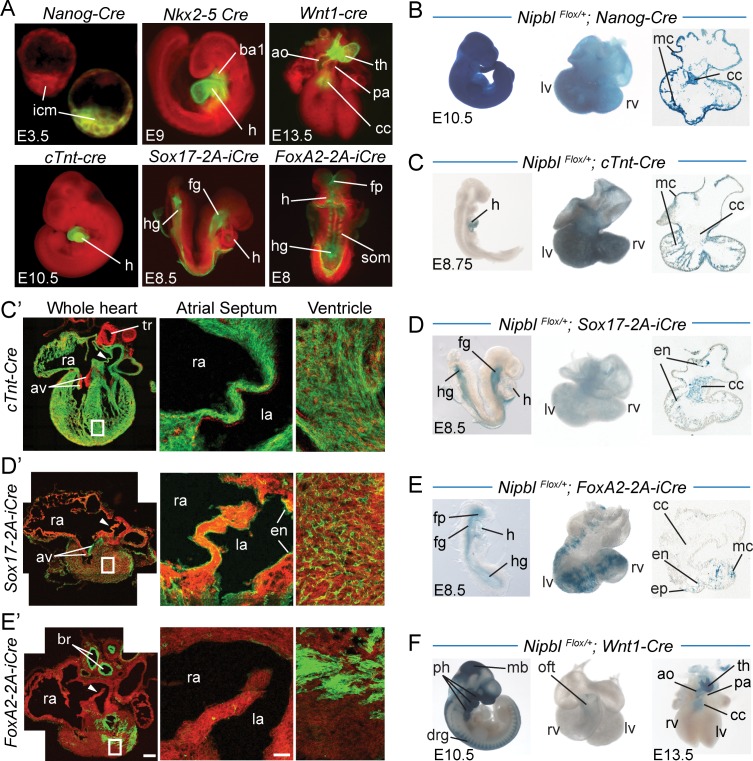
Domains of Cre expression in mice made Nipbl-deficient in different heart developmental lineages.A. Relevant patterns of Cre expression from the six Cre lines used in this study (Nanog-Cre, Nkx2-5-Cre, cTnt-Cre, Sox17-2A-iCre, FoxA2-2A-iCre, Wnt1-Cre), assessed on the Td-Tomato-EGFP reporter during early embryogenesis. Cre-mediated recombination is indicated by expression of EGFP. Note two embryos are shown in the Nanog-Cre panel; only the embryo on the right carries the Nanog-Cre allele and exhibits EGFP expression in the inner cell mass (icm). B–F. X-gal staining was performed to detect expression of β-geo in NipblFlox/+ embryos carrying one of the Cre transgenes. X-gal staining was assessed in whole embryos (at E8–10.5, left panels), whole hearts (at E10.5, middle panels in B-E and at E13.5 in NipblFlox/+;Wnt1-cre hearts, right panel in F), and sectioned hearts (at E10.5, right panels B-E). C’–E’. Confocal images of E15.5 hearts generated from crosses of NipblFlox/+;Td-Tomato-EGFP mice with different Cre-expressing lines. (C’) cTnt-Cre: EGFP in myocardium including atrial septum. (D’) Sox17-2A-iCre: EGFP in endocardium, and small blood vessels. (E’) FoxA2-2A-iCre: EGFP in both endoderm (bronchi linings) and some mesoderm (muscle in ventricle); minimal EGFP expression in atrial septum (note that pattern is different from Sox17-2A-iCre). ao, aorta; av, atrioventricular valve; ba1, branchial arch; br, bronchi; cc, cardiac cushion; drg, dorsal root ganglion; en, endocardium; ep, epicardium; fp, floor plate; fg, foregut; h, heart; hg, hindgut; icm, inner cell mass; la, left atria; lv, left ventricle; mb, midbrain; mc, myocardium; oft, outflow tract; pa, pulmonary artery; ph, pharyngeal arches; ra, right atria; rv, right ventricle; som, somites; th, thymus; tr, trachea